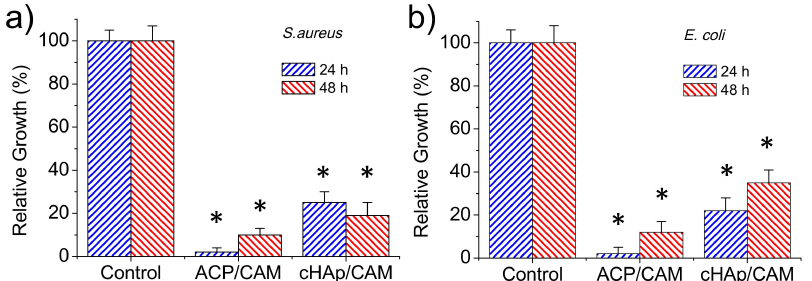
Figure 8. Relative growth of S. aureus ( a ) and E. coli ( b ) bacteria in the control and CAM loaded ACP and cHAp nanoparticles. * p < 0.05 vs. control.